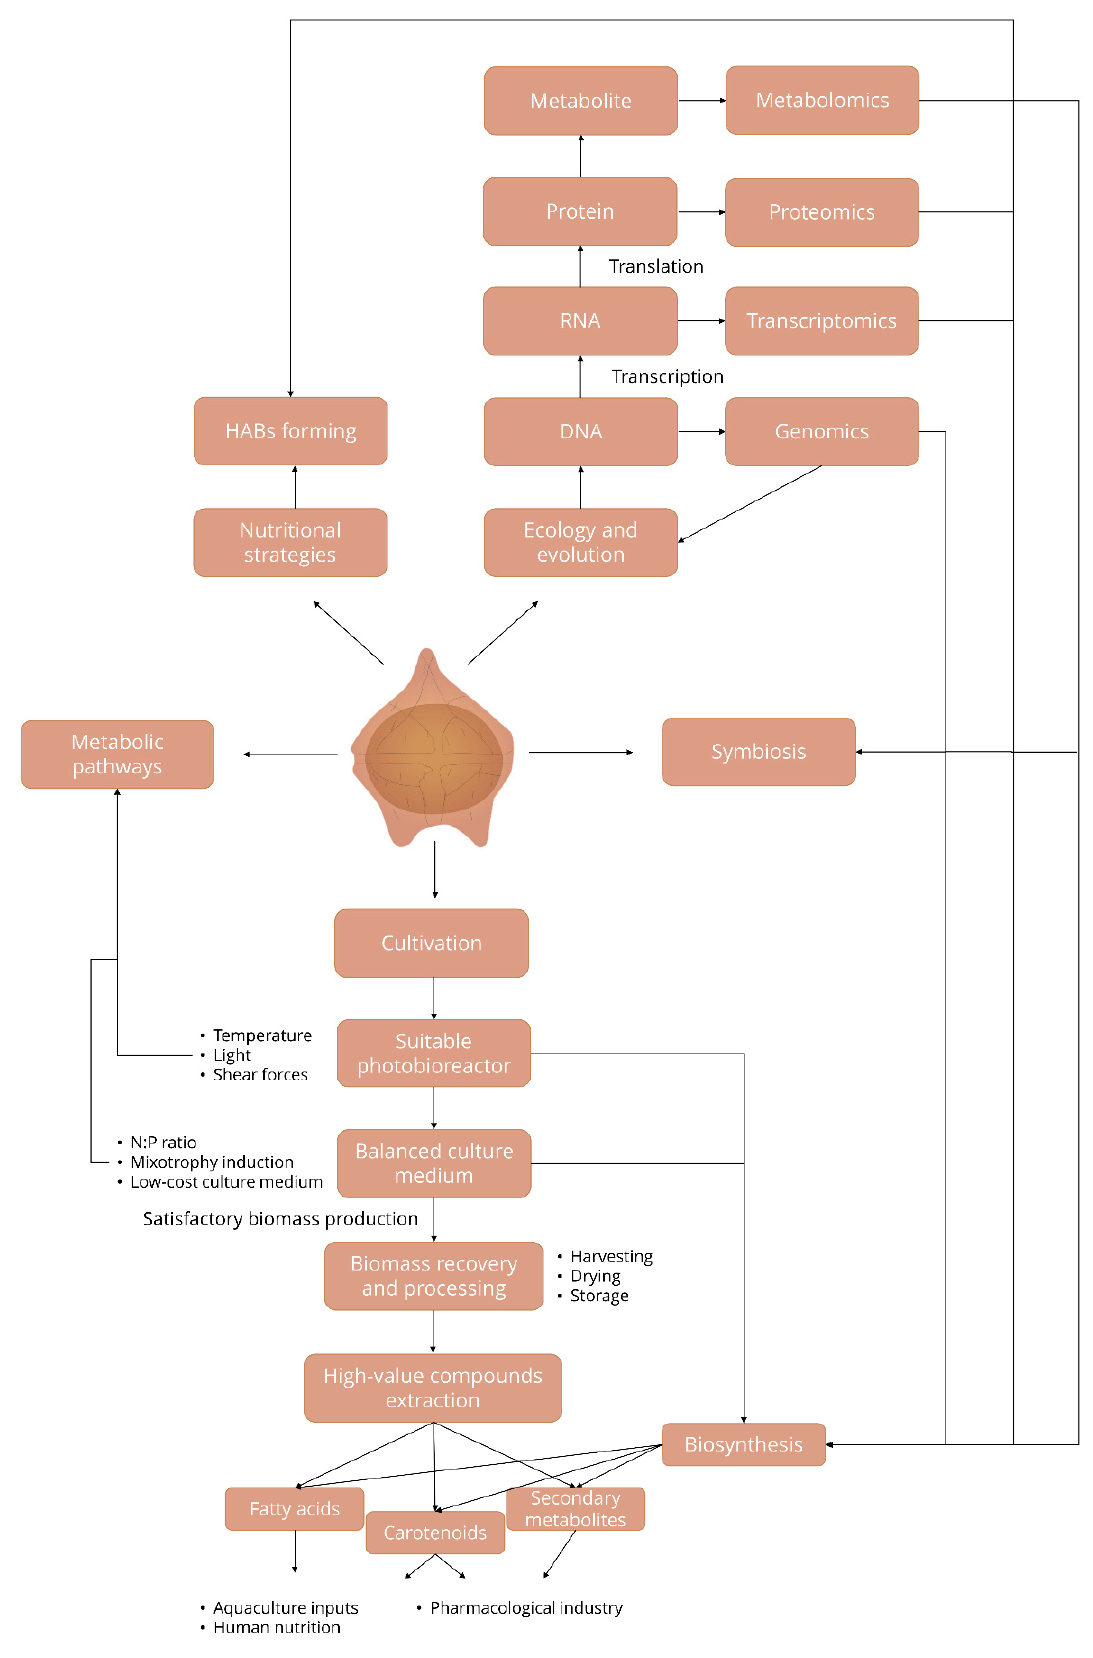
Figure 7. Perspectives for future dinoflagellate research.